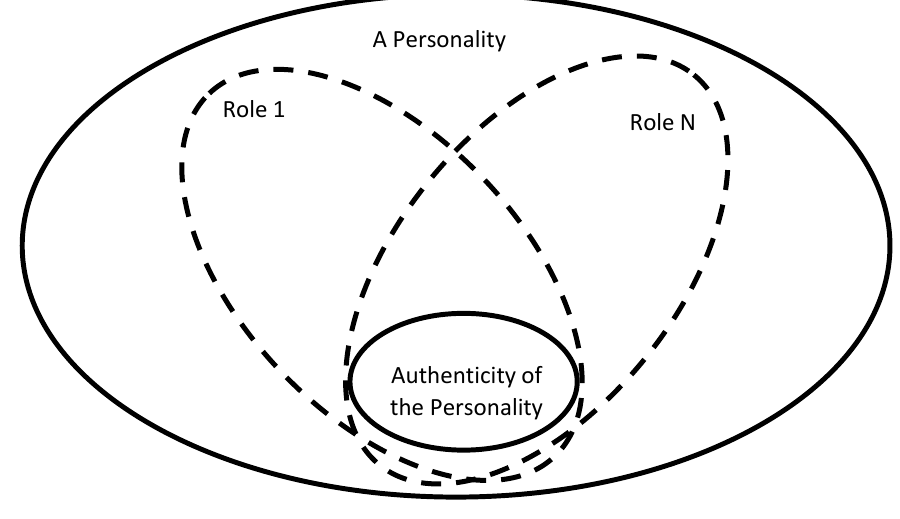
Figure 1. A Personality Conceptual